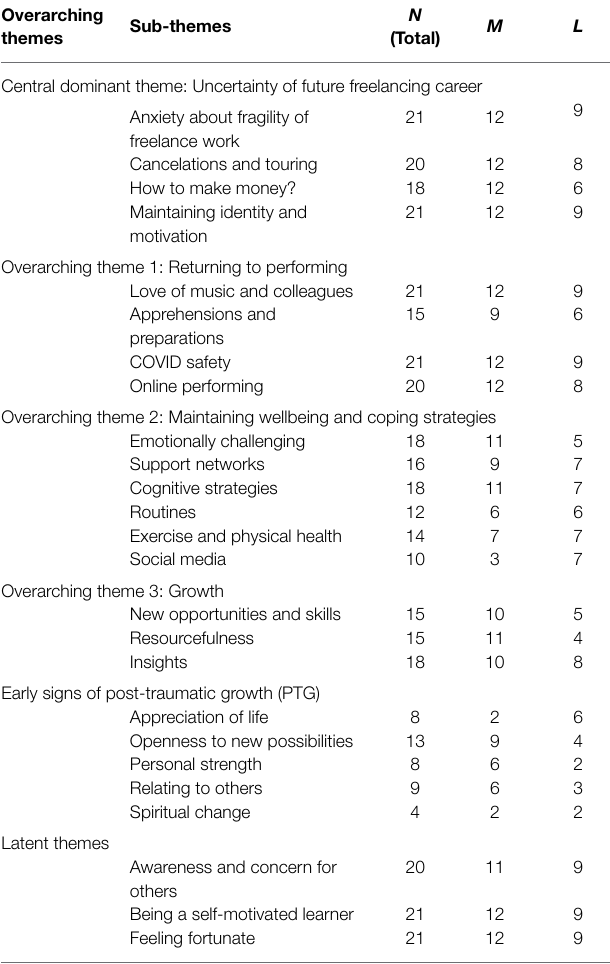
TABLE 2 | Central dominant theme, overarching themes, sub-themes, group, and number of participants for each sub-theme. Overarching